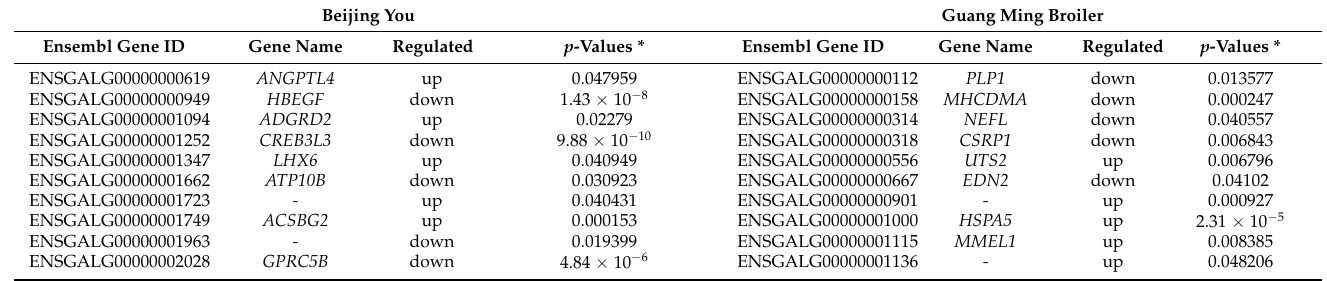
Table 1. DEGs of Beijing You and Guang Ming broiler chicken in response to heat stress